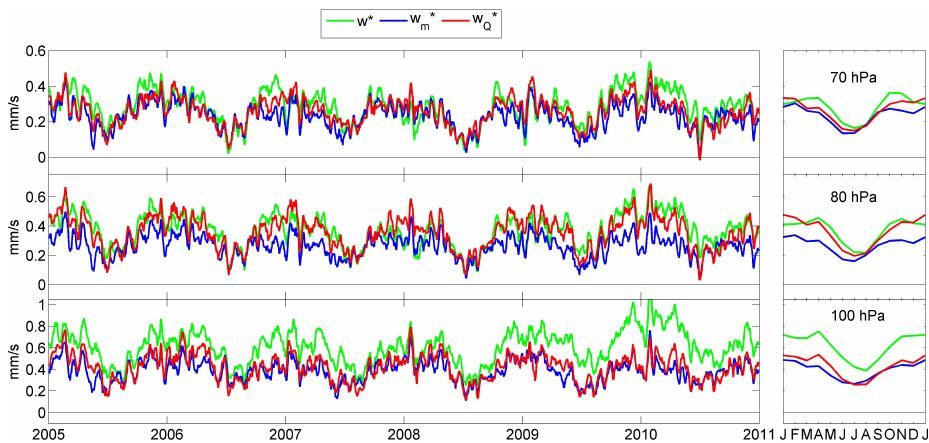
). 11-days running Q